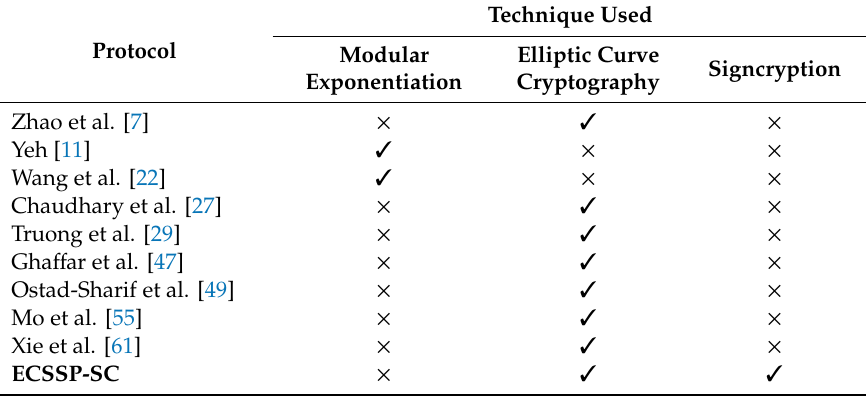
Table 3. Technique used in di ff erent smart card authentication